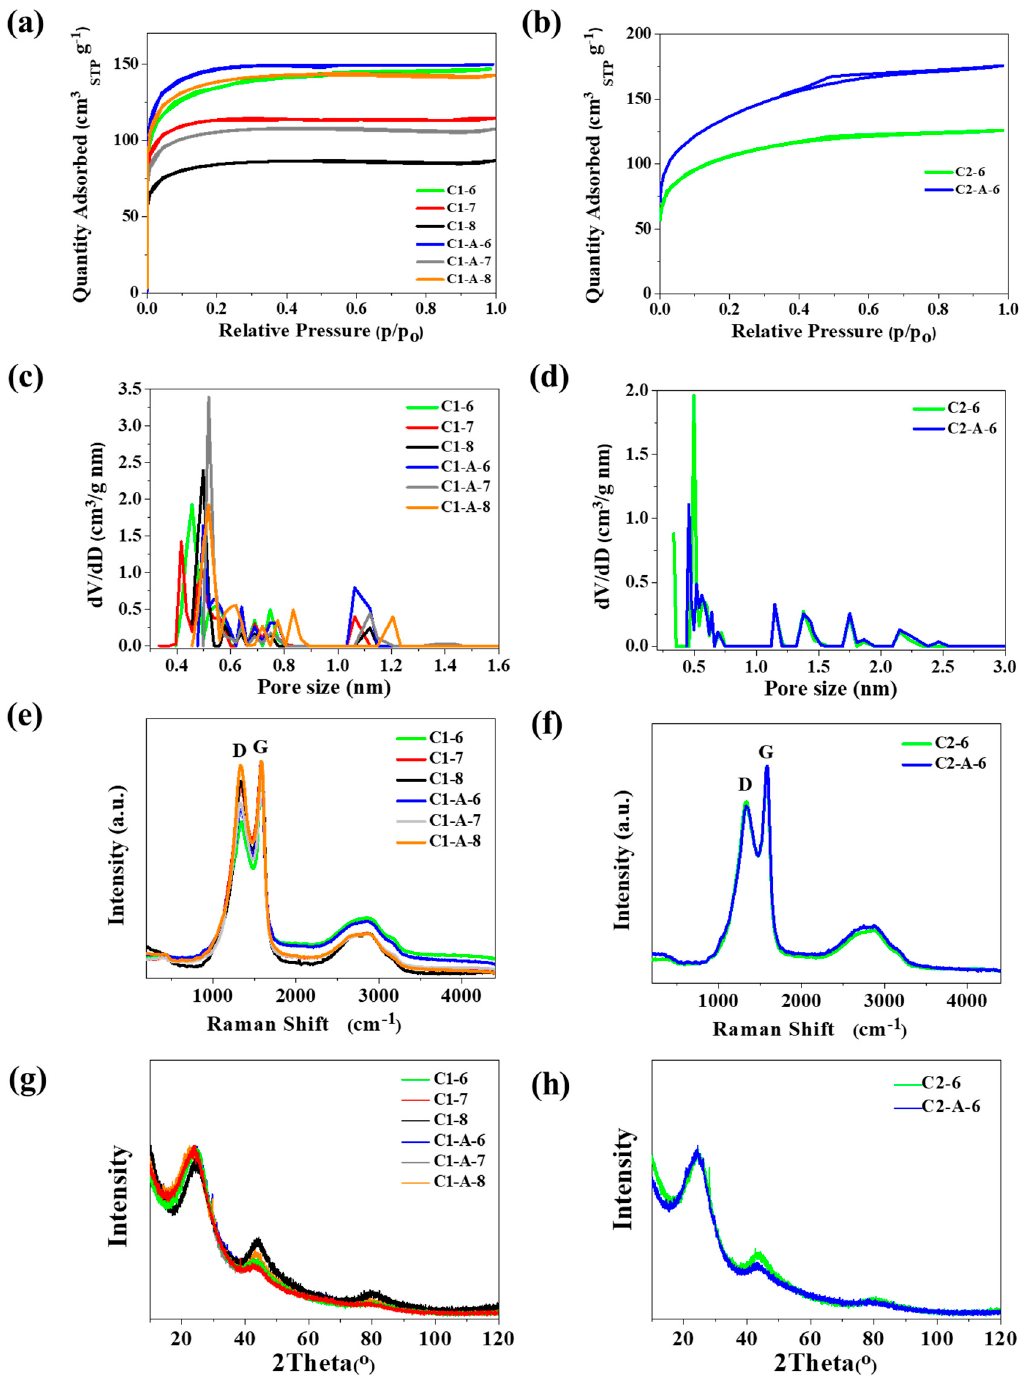
Figure 3. ( a , b ) Nitrogen adsorption-desorption isotherms; ( c , d ) Pore size distribution by nonlocalized density functional theory (NLDFT) method; ( e , f ) Raman spectra for samples C1-A-T, C1-T, C2-A-6, and C2-6; XRD patterns of ( g ) C1-A-T and C1-T; and ( h ), C2-A-6, and C2-6 sample.